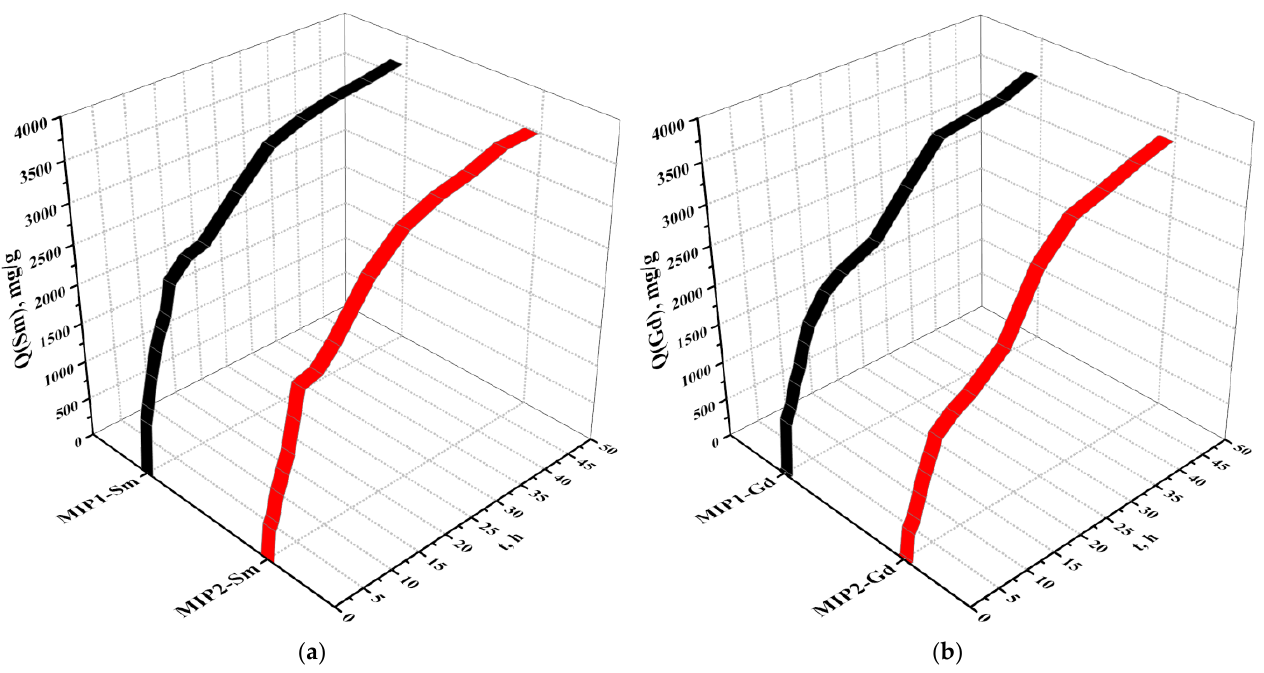
Figure 6. Exchange capacities (in relation to samarium ( a ) and gadolinium ( b )) of imprinted structures MIP1, MIP2. Table 3. Values of exchange capacity (in relation to samarium and gadolinium) of imprinted structures MIP1 and